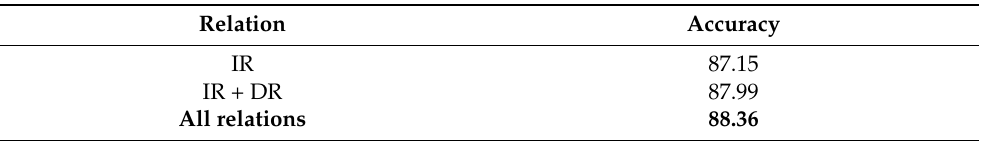
Table 6. Classification accuracy (%) of HFGNN-Proto with different relation combinations on ARSC. IR stands for instance-level relations and DR stands for Distribution-level relations.